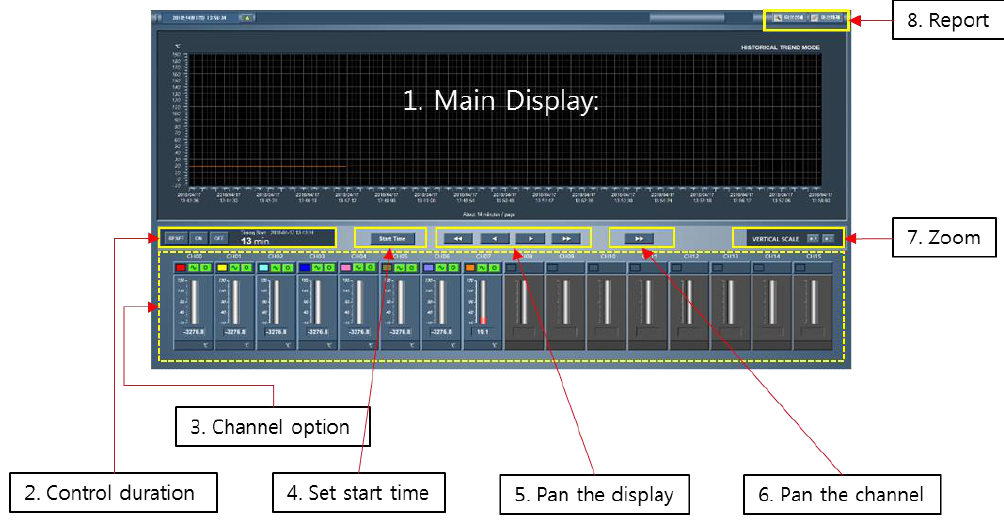
Figure 3. User interface showing measured temperature history from the networks.